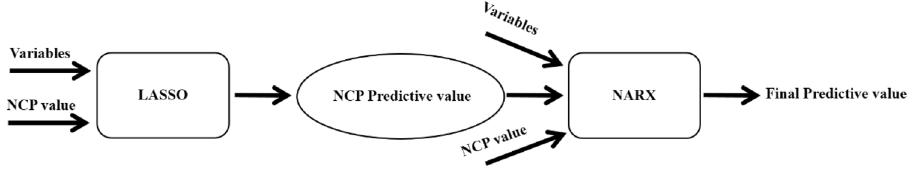
Figure 1. The flux diagram of the regression process, where NCP represents the concentration of pollutants measured at the national control